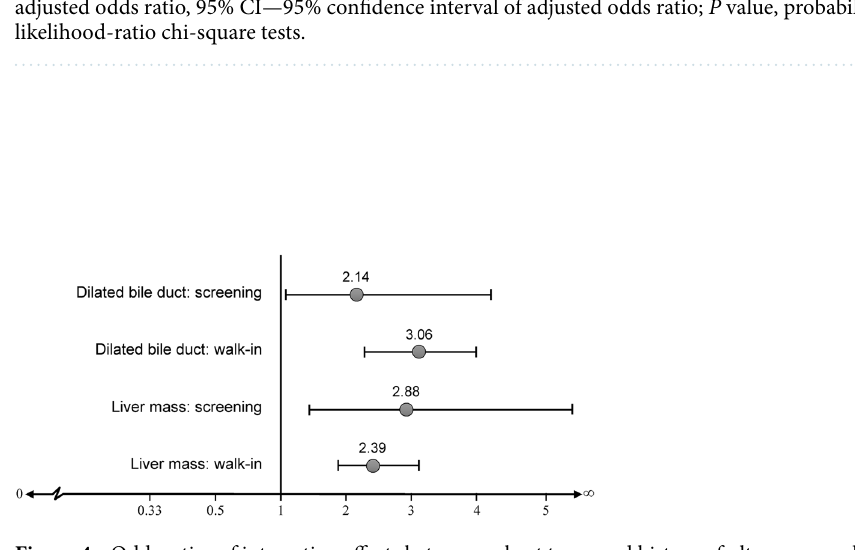
Figure 4. Odds ratios of interaction effects between cohort types and history of ultrasonography findings with cholangiocarcinoma association adjusted for age at enrollment, liver parenchymal change, cohort types, dilated bile duct, and liver